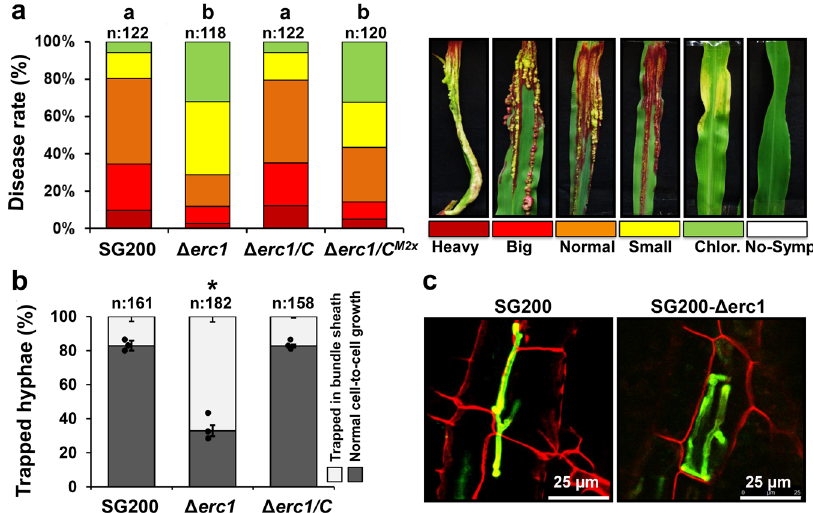
Fig. 1 | Erc1 is a virulence factor that is involved in cell-to-cell extension in maize. a Disease symptoms caused by Ustilago maydis SG200, SG200 Δ erc1 mutant, SG200 Δ erc1/C strain, and SG200 Δ erc1/Erc1 M2x on Early Golden Bantam (EGB) maize leaves at 12 days post inoculation (dpi). Disease rates are given as a percentage of the total number of infected plants. n: indicates total number of infected maize seedlings in three independent biological experiments and letters above bars indicate signi fi cant differences (One-way ANOVA followed by Tukey multiple comparison test was performed, p <0.05). b Quanti fi cation of cell-to-cell penetration ef fi ciency of SG200, SG200 Δ erc1 and SG200 Δ erc1/C complementa- tion strains. The graph depicts the percentage of trapped U. maydis hyphae in